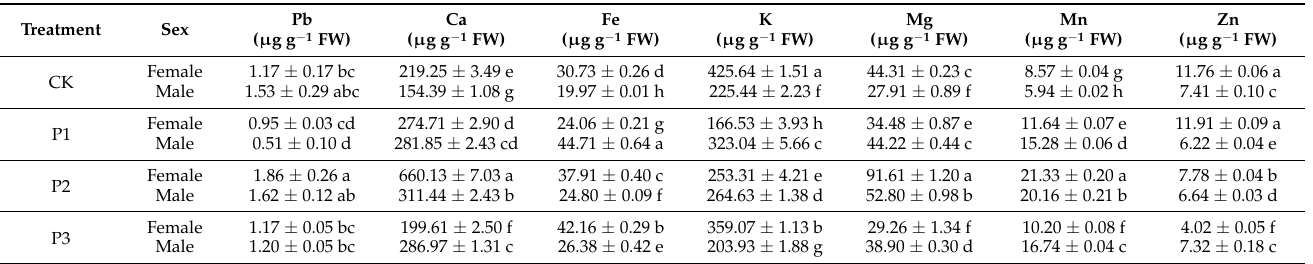
Table 1. Elemental concentrations in the chloroplast and cell nuclei fractions of L. cubeba female and male leaves under control and Pb